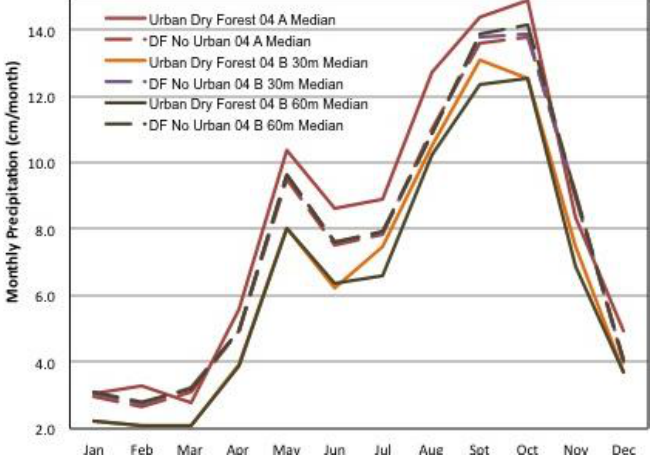
Figure 13. Median monthly precipitation for dry forest 2004 urban vs. non-urban.